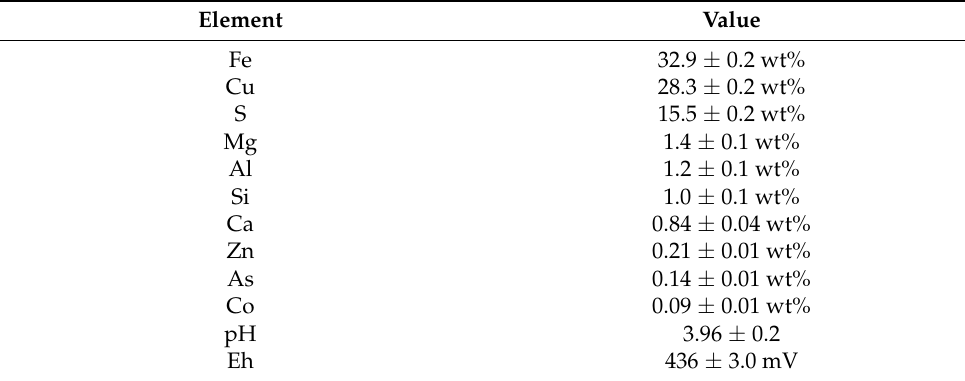
Table 1. pH, Eh, and elemental composition of CPY sample.